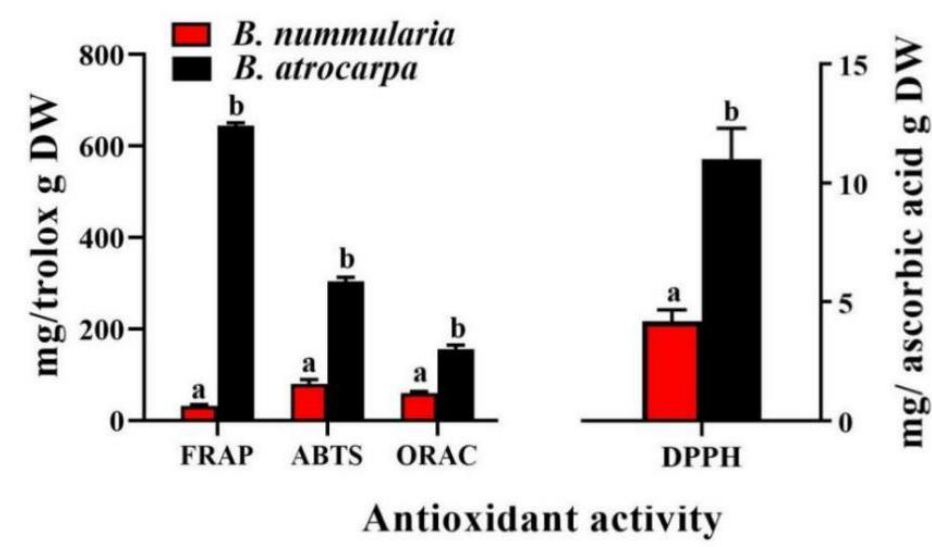
Figure 4. The antioxidant activity of B. nummularia and B. atrocarpa fruits. Mean ± SD indicate three replicates. Different letters indicate significant difference ( p < 0.05).